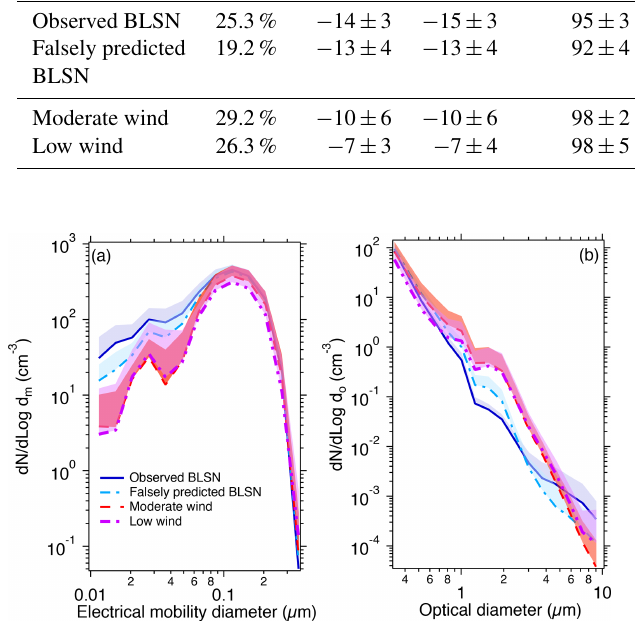
Figure 3. Size distributions of particle number concentrations dur- ing observed BLSN, falsely predicted BLSN, moderate wind, and low wind periods from (a) SMPS measurements (0.01–0.42µm electrical mobility diameter; 4 April–7 May) and (b) OPS measure- ments (0.3–10µm optical diameter; 18 April–7 May). The shadings are the upper bounds of the standard deviation of dN/dlog d m (or dN / dlog d o ). Since the y axis is on a log scale, only the upper bound of the standard deviation is shown. Particles larger than ∼ 4µm were at very low concentrations, and those larger than 5.3µm experienced more than 25% sampling line losses, such that particles > 4µm thus are not used in the discussed data analysis because of the impact of reduced